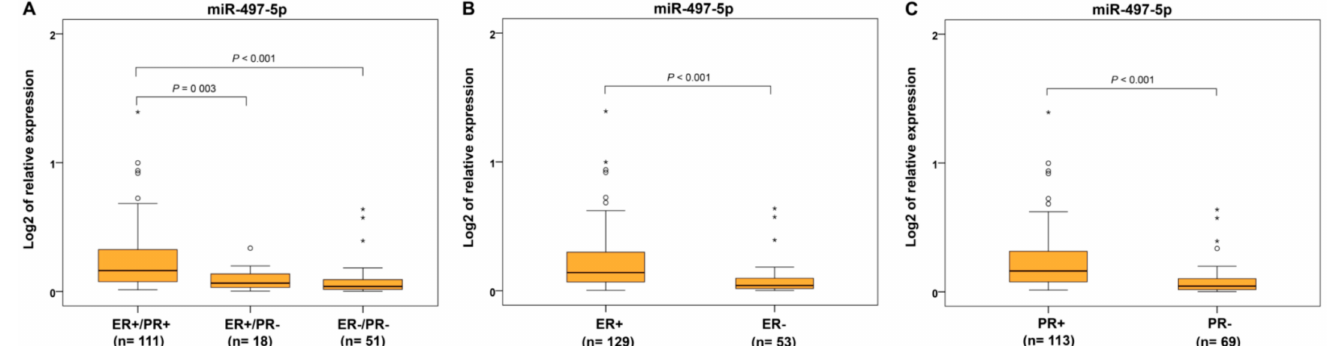
Figure 5. Relative expression of miR-497-5p in endometrial carcinomas with different hormonal receptor status. Differential expression between endometrial carcinomas grouped according to estrogen (ER) and progesterone (PR) receptor expressions, namely ER+/PR+, ER+/PR − , and ER − /PR − ( A ); carcinomas with estrogen receptor expression in 1% and >1% of positively responding cells (ER+ and ER − ) ( B ); carcinomas with progesterone receptor expression in 1% and >1% of positively responding cells (PR+ and PR − ) ( C ). The length of the boxes is the interquartile range (IQR) that represents values between the 75th and 25th percentiles. ( ) labels outliers (values greater than 1.5 IQRs and less than 3 IQRs from the end of the box). (cid:35) (*) represents values greater than three IQRs. The horizontal line depicts the median. Statistical significance is regarded as p < 0.05.